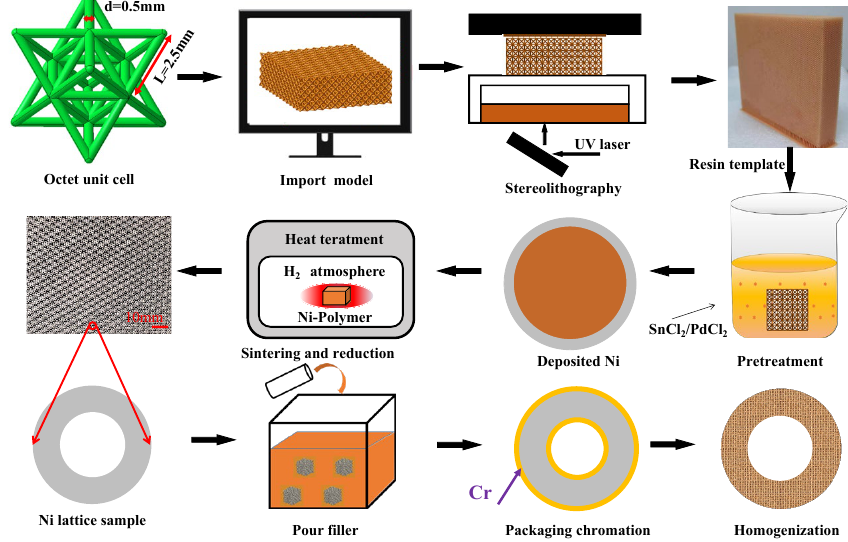
Figure 1. Schematic diagram of the preparation process of NiCr alloy lattices.